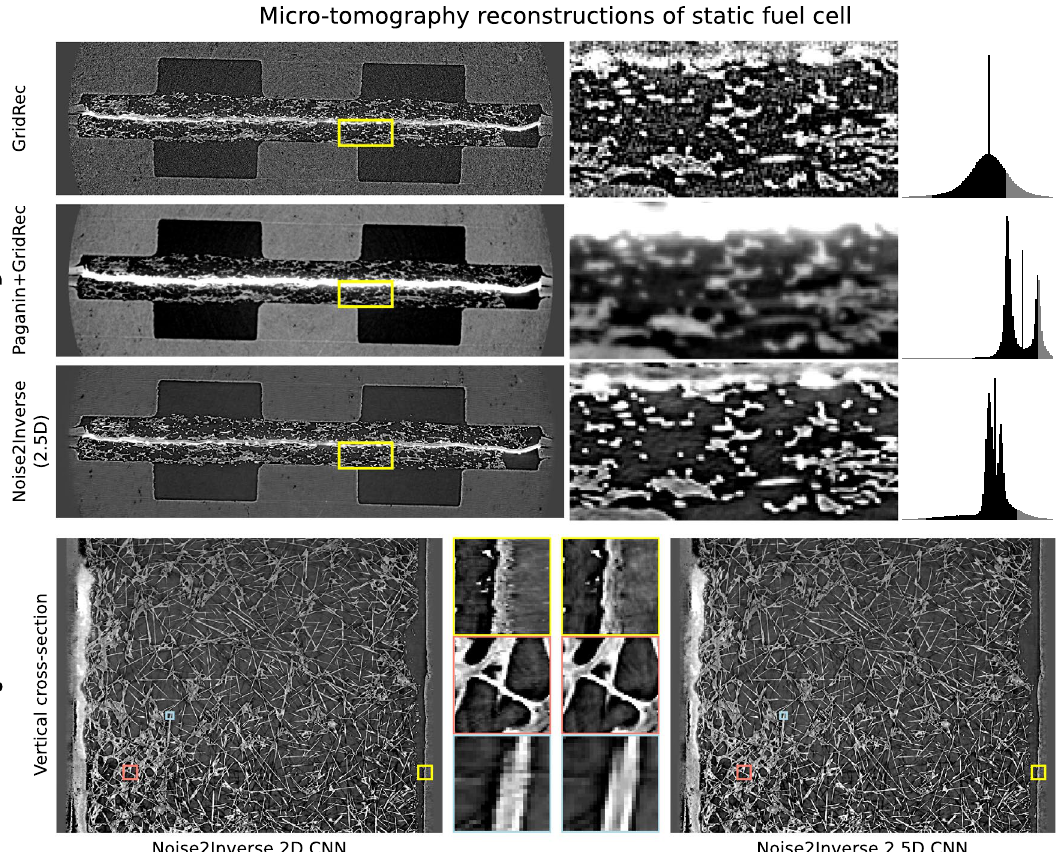
Figure 4. Comparison of reconstructions of a fuel cell using GridRec, Paganin+GridRec, and Noise2Inverse. ( a ), Reconstructions of the static fuel cell. The yellow region of interest is magnified in the windows on the right. Gray level ranges have been adjusted to improve contrast and are indicated by the shaded region in the histograms on the right. ( b ), A comparison of Noise2Inverse with a 2D CNN and a 2.5D CNN on a vertical cross-section of the reconstruction. The magnified regions of interest in the middle reveal discontinuities in the 2D CNN